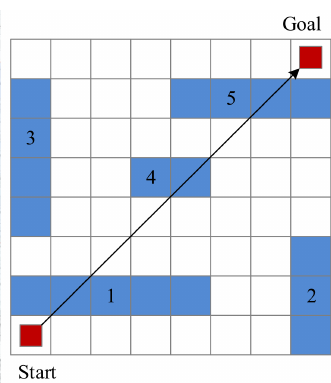
Figure 8. Visibility tree search.